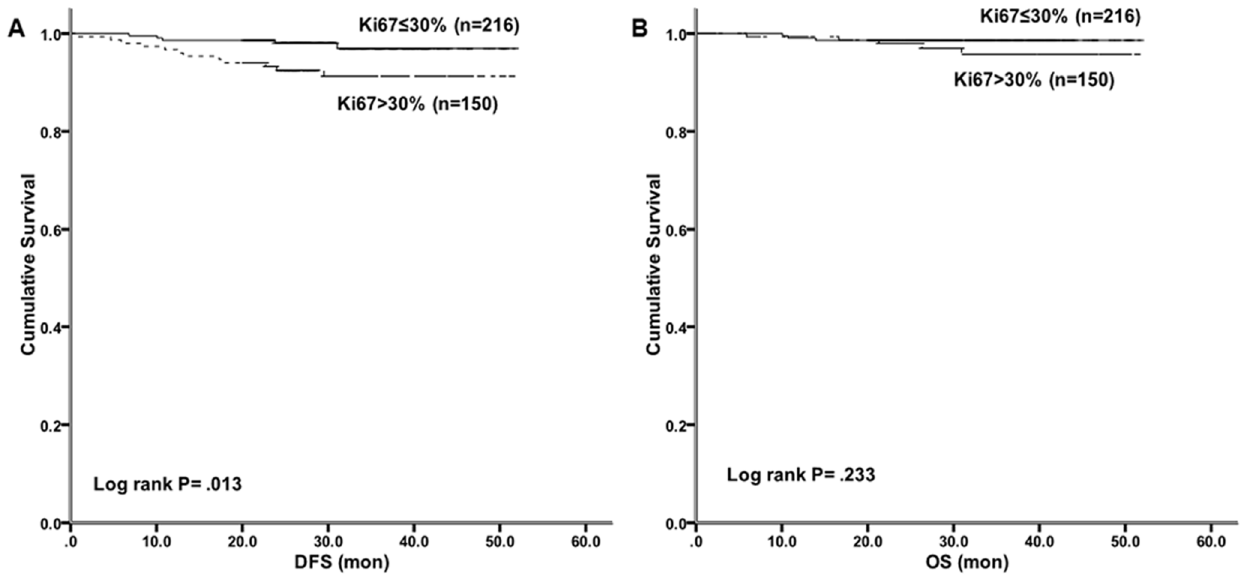
Figure 2. Disease-free survival and overall survival by high/low Ki-67 index among Luminal B/HER2- patients. (A) A significantly better 2-year DFS was detected in the high Ki-67 index group when compared to the low Ki-67 index group (98.0%Vs 92.4%, Log-rank p=.013). (B) No significant overall survival difference was detected between the high Ki-67 index group and the low Ki-67 index group (98.3% Vs 97.0%, Log-rank p=.233).